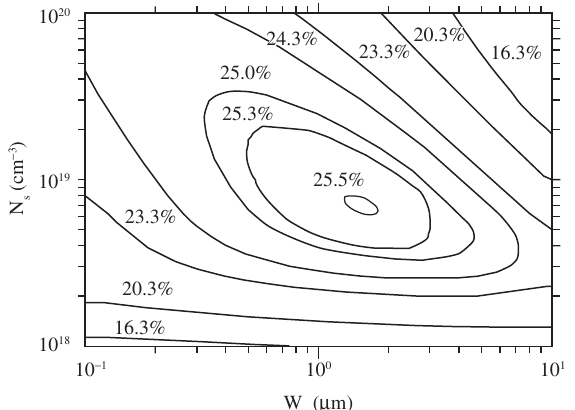
Figure 9. Short-circuit current density contour plots, J tion of surface doping concentration, N solar cell with base resistivity 1 Ω